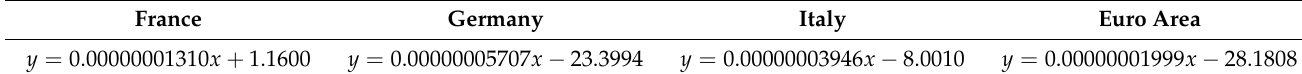
Table 2. Regression models of stage 2 (source: own work).